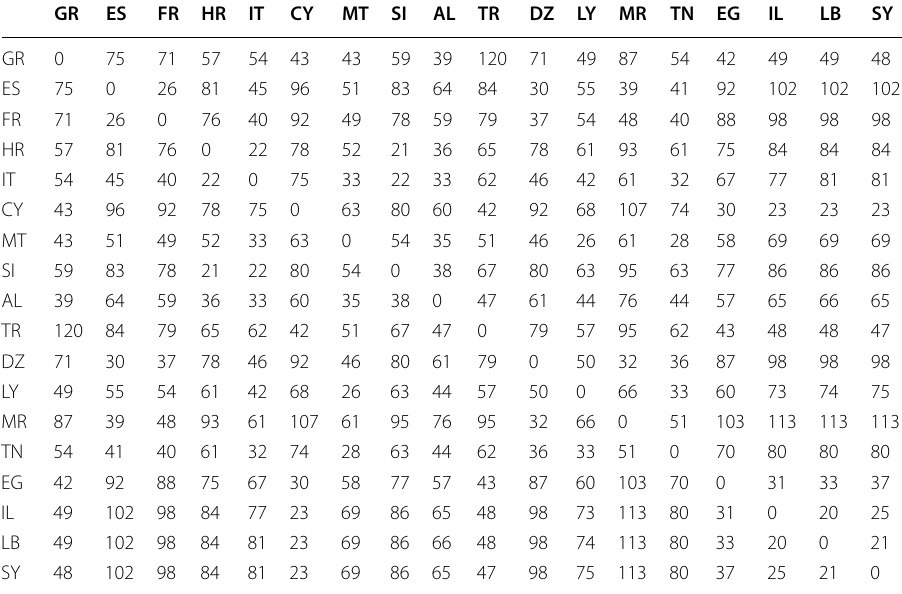
Table 4 O/D Matrix-time distances for container transport